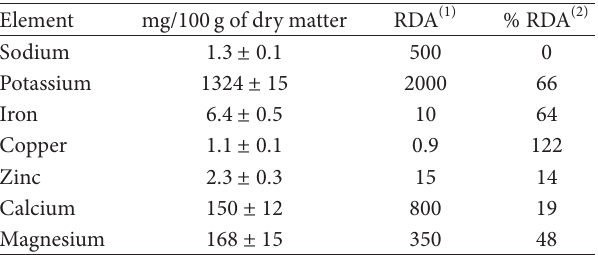
T 2: Mineral composition of the fruits of Ilex